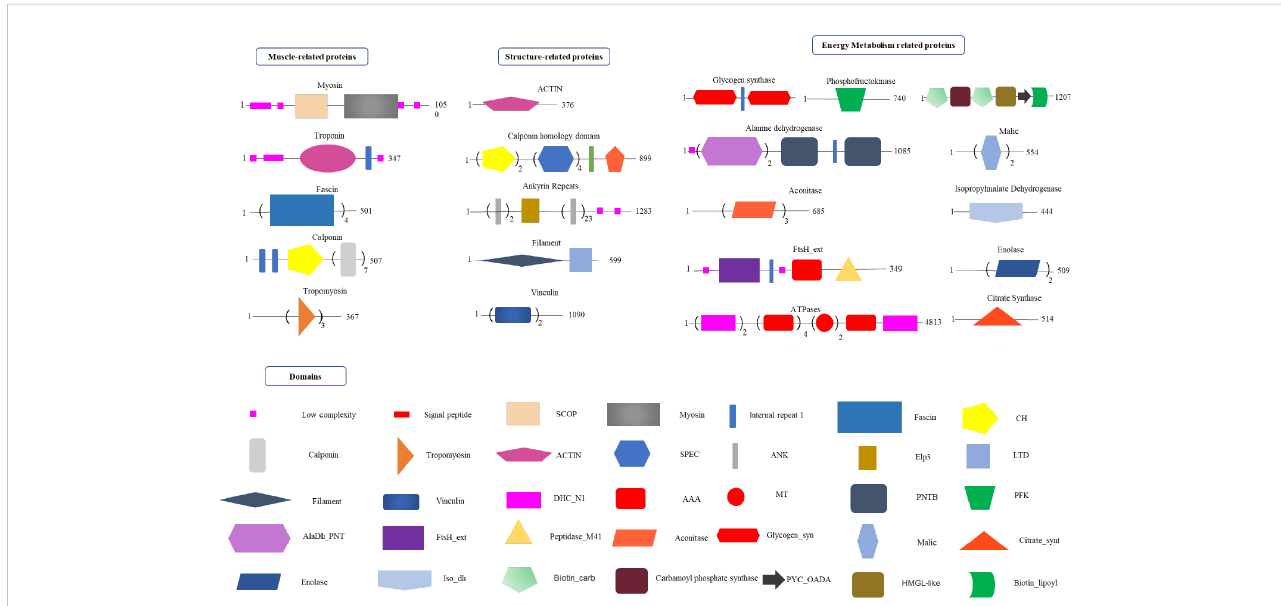
FIGURE 5 Proteomics analysis of radular muscles. Three types of proteins that are abundant in muscles were manually divided including muscle-related, structure- related, and energy metabolism-related proteins. Domains were predicted by the SMART website. AAA, ATPases associated with a variety of cellular activities; AlaDh_PNT, Alanine dehydrogenase/PNT, N-terminal domain; ANK, ankyrin repeats; Biotin_carb, Biotin carboxylase; CH, Calponin homology domain; DHC_N1, Dynein heavy chains; Elp3,Elongator protein 3; FtsH_ext, FtsH Extracellular; HMGL-like, Pyruvate carboxylase; Iso_dh, Isocitrate/ isopropylmalate dehydrogenase; LTD, C-terminal lamin-tail domain; MT, Microtubule-binding stalk of dynein motor; PNTB, NAD(P) transhydrogenase beta subunit; PFK, Phosphofructokinase; PYC_OADA, Conserved carboxylase domain; SPEC, Spectrin